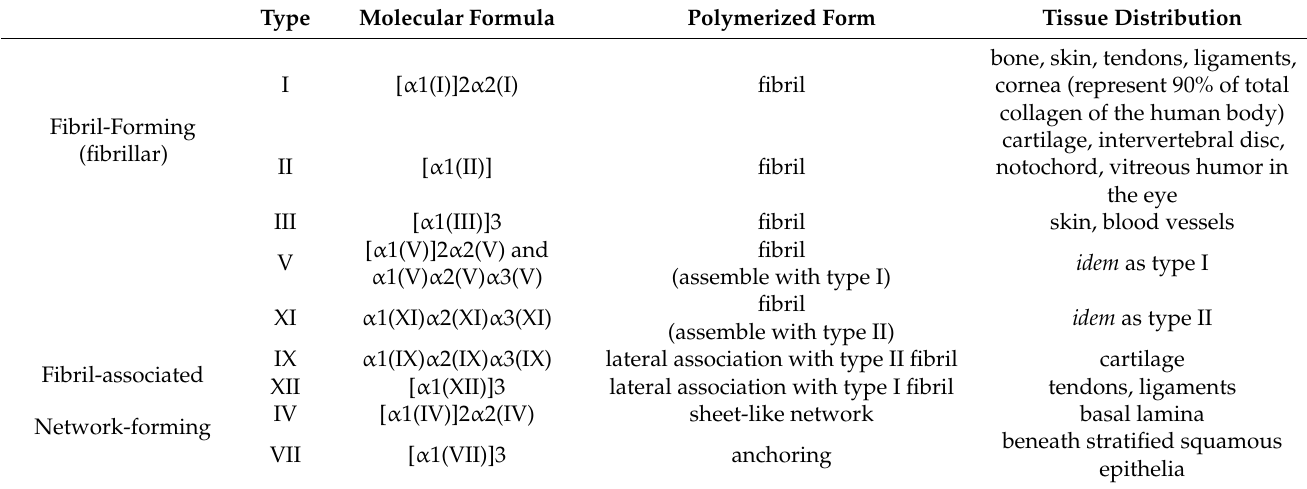
Table 1. Collagen types, molecular formula, and tissue distribution. Reproduced from [46] with permission. Copyright (2010) MDPI